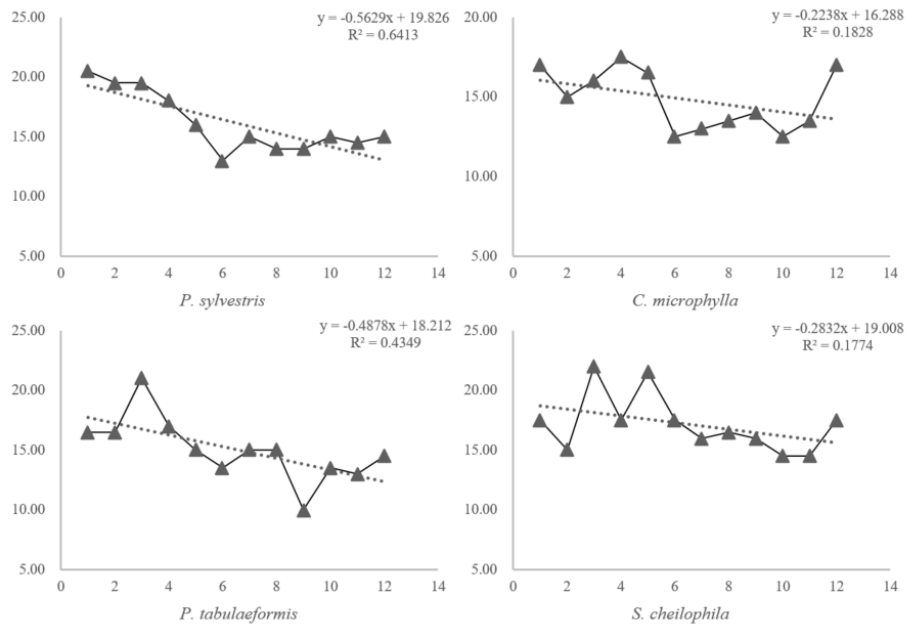
Figure 3. Soil moisture (%) changes with the interval days.